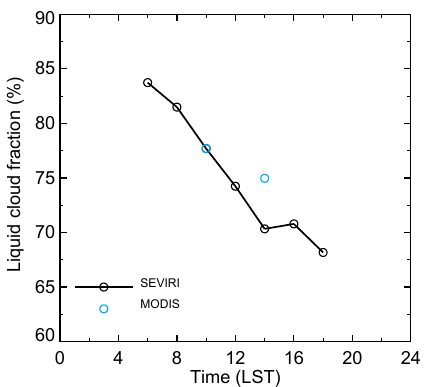
Figure 10. The 2-year-mean diurnal cycle of SEVIRI LCF over the Sc region for the all-sky case. MODIS Terra and Aqua values are also plotted. Rain-, ice-, and smoke-free conditions were